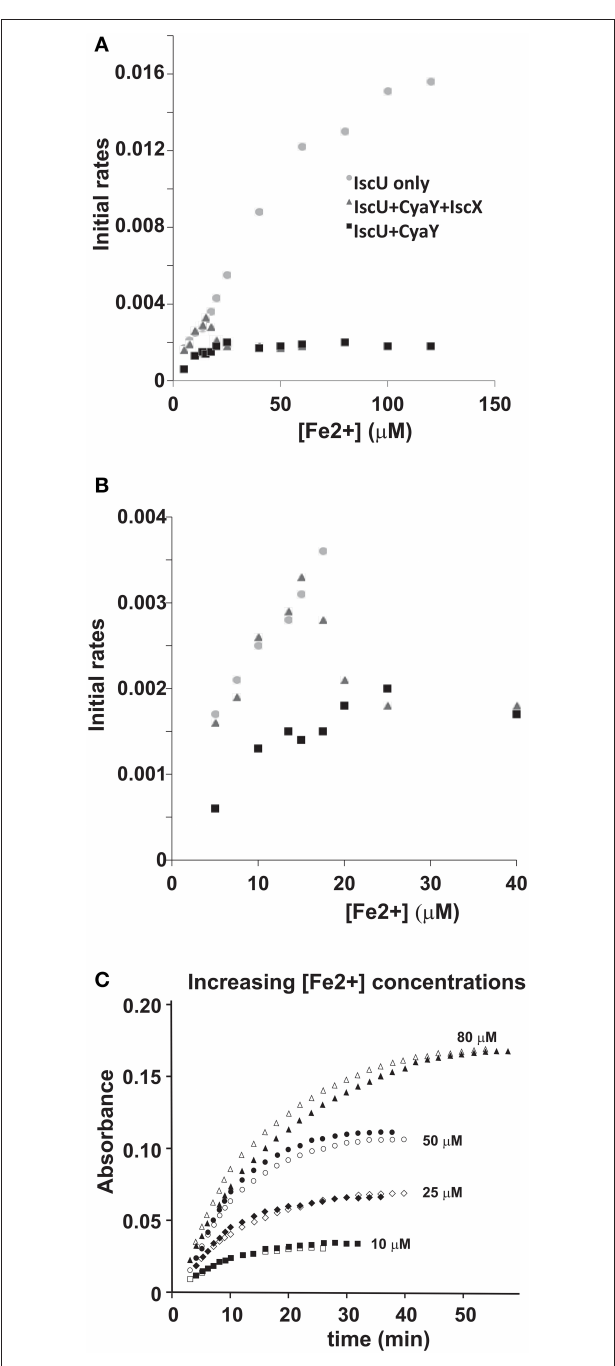
FIGURE 7 | Iron dependence of the relative effect of CyaY and IscX on cluster assembly enzymatic kinetics on IscU. (A) Initial rates of kinetics of cluster formation on IscU as a function of iron concentration in the presence of IscU only (gray circle), IscU and CyaY (black rectangles) and IscU, IscX, and CyaY (gray triangles). (B) The same as in (A) but expanded for clarity. (C) Assays carried out in the absence and in the presence of IscX (1 µ M) at increasing concentrations of iron (10 µ M, 25 µ M, 50 µ M, 80 µ M) to assess whether IscX is affected by iron. No CyaY was added to the assay. All experiment contained 1 µ M IscS, 50 µ M IscU, 250 µ M Cys, 2mM